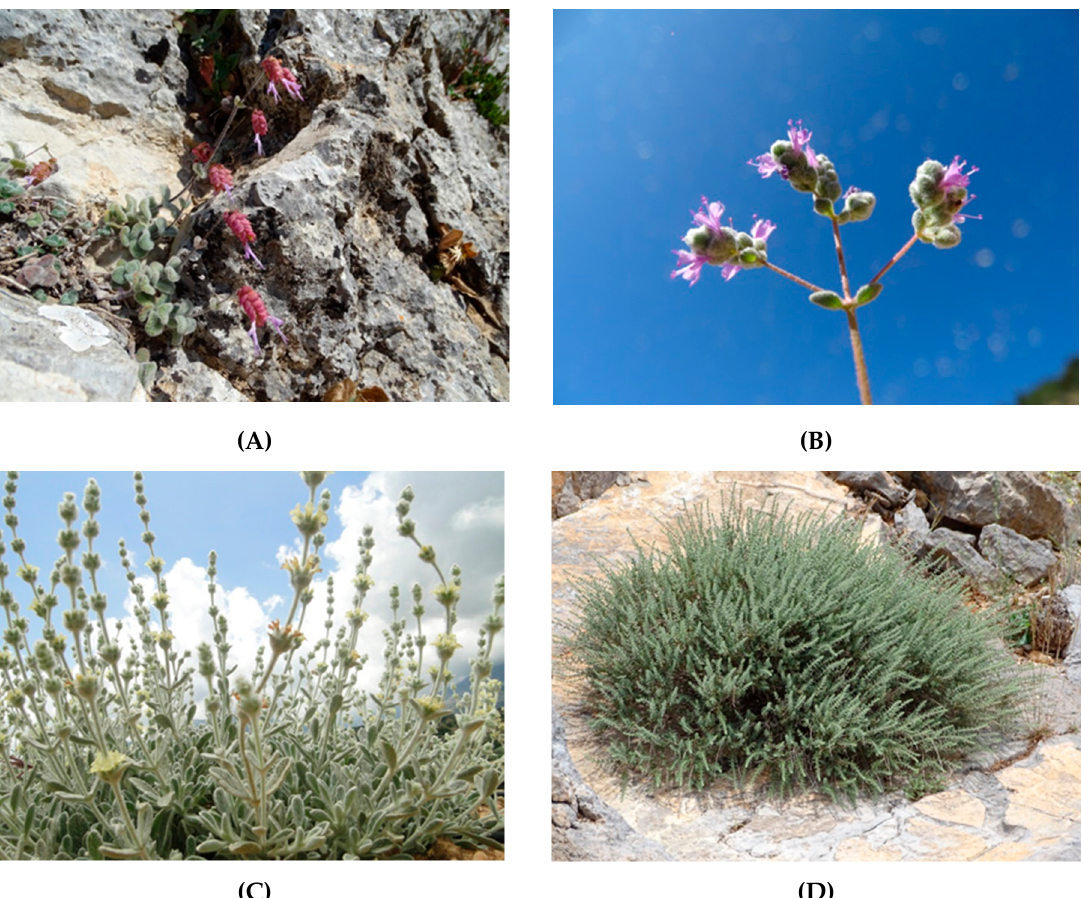
Figure 2. Four top-evaluated Cretan endemic plants of Lamiaceae family, in terms of maximum possible score achieved regarding their agro-alimentary potential (Photos: N. Krigas). ( A ): Origanum dictamnus , ( B ): Origanum microphyllum , ( C ): Sideritis syriaca subsp. syriaca , ( D ): Thymbra calostachya . For these plants, propagation material has been collected from the wild to allow ex-situ conservation and propagation-cultivation trials at the Institute of Plant Breeding and Genetic Resources, Hellenic Agricultural Organization Plants 2021 , 10 , x. https://doi.org/10.3390/xxxxx